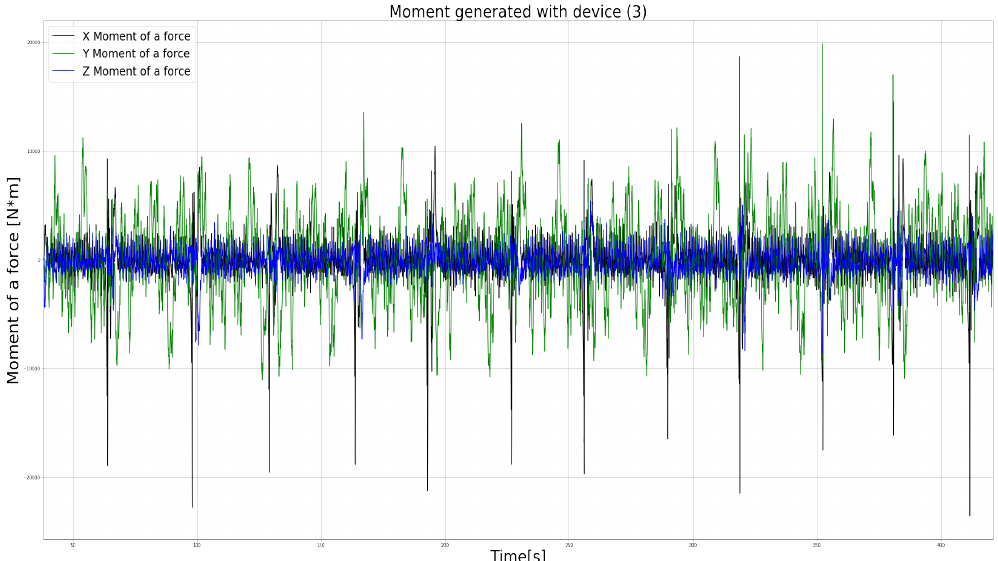
Figure 1. Generated moments for Measurement (3) in walk–fall